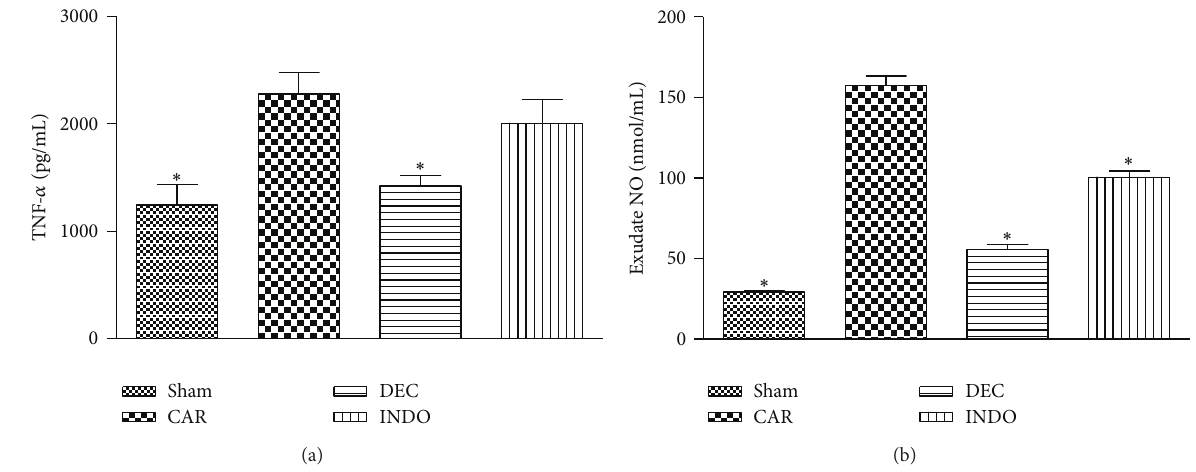
Figure 9: Effect of DEC on carrageenan-induced TNF- 𝛼 and NO production in the lung. (a) TNF- 𝛼 levels were significantly elevated 4h after carrageenan administration in the CAR group in comparison to the sham group. DEC significantly reduced the TNF- 𝛼 level, but INDO did not reduce TNF- 𝛼 level in comparison to the CAR group. Nitrite and nitrate levels, stable NO metabolites, were significantly increased in the pleural exudates 4h after carrageenan administration in comparison to the sham group. DEC and INDO significantly reduced the nitrite and nitrate level in the exudates (b). Data expressed as mean ± S.E.M. from 𝑛 = 8 mice for each group; ∗ 𝑃 < 0.05 versus